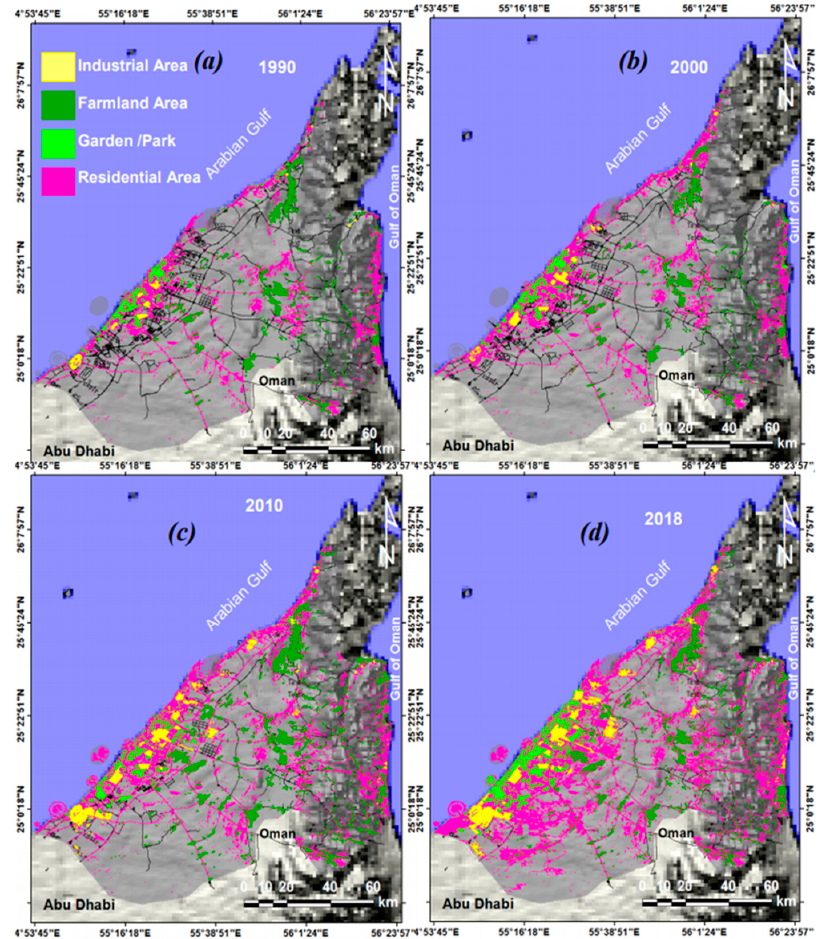
Table 4. LULC classes estimation (in km 2 and percentage) for the years 1990,2000,2010, and 2018 1 Figure 6. Spatiotemporal variation of built-up and vegetation areas of the NUAE during 1990, 2000, 2010, and 2018. Bare land such as sand dune, desert plain, Ophiolite rock was excluded.